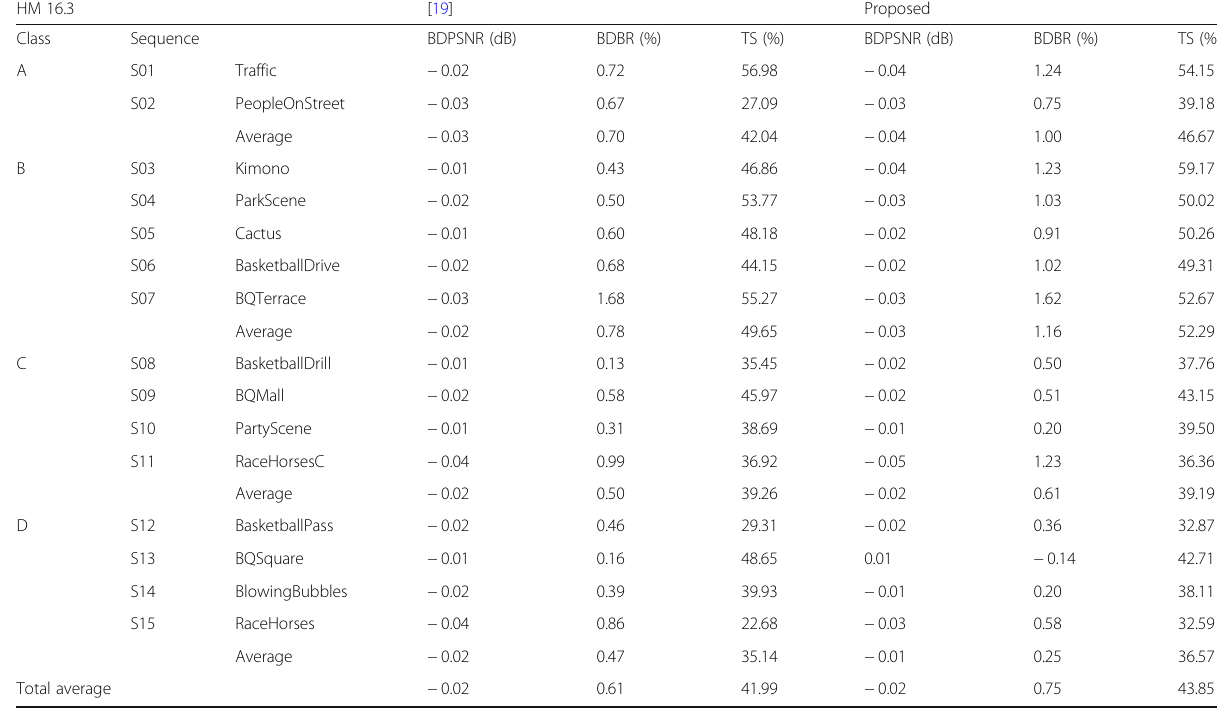
Table 4 Performance comparison between the proposed method and [19] under the random-access configuration HM 16.3